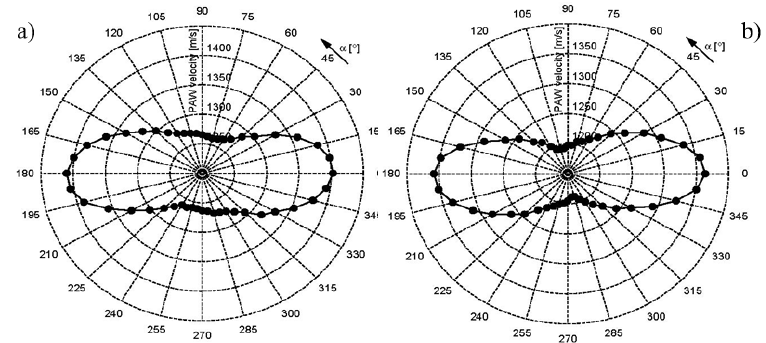
Figure 6. Flexural wave velocity anisotropy in quasi-isotropic CFRP laminates: [0/45/ − 45/90]s ( a ) and [0/60/ − 60]s ( b ).